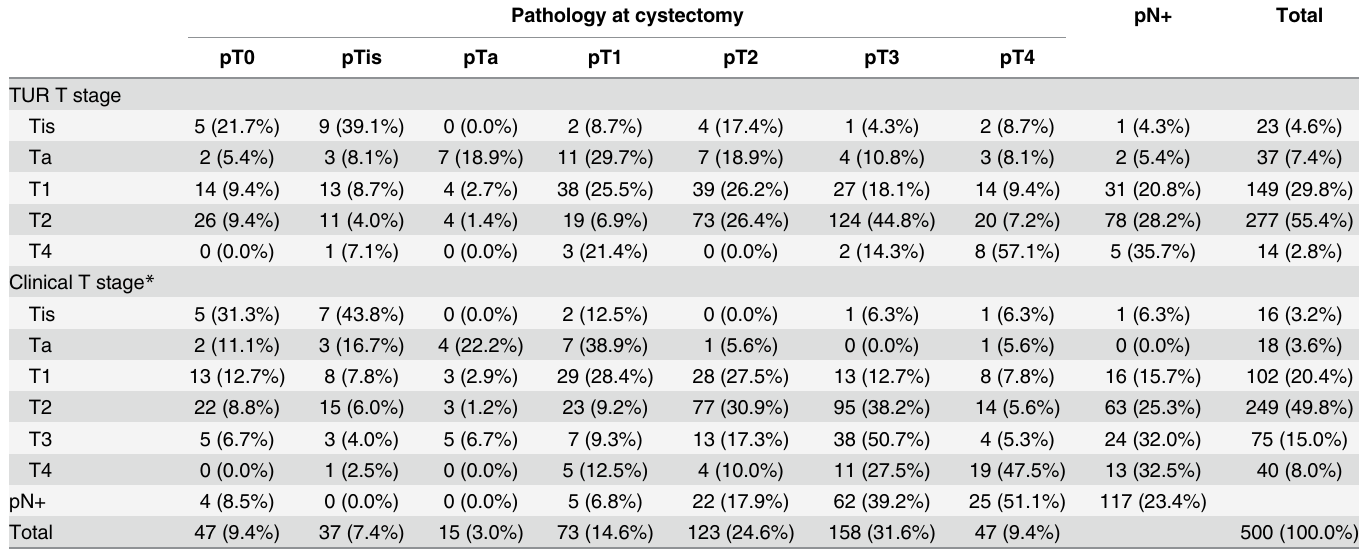
Table 2. Cross-tabulation between T stage at transurethral resection and clinical T stage and pathologic stage at cystectomy. Pathology at cystectomy